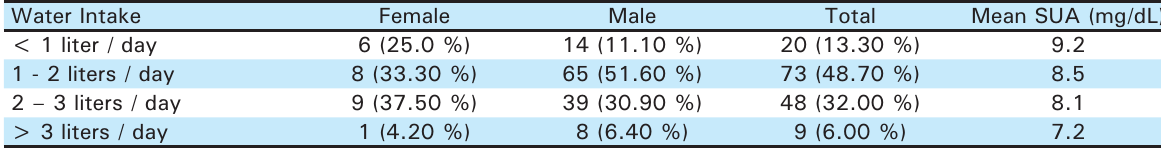
Table 4: Amount of water intake and serum uric acid level Water